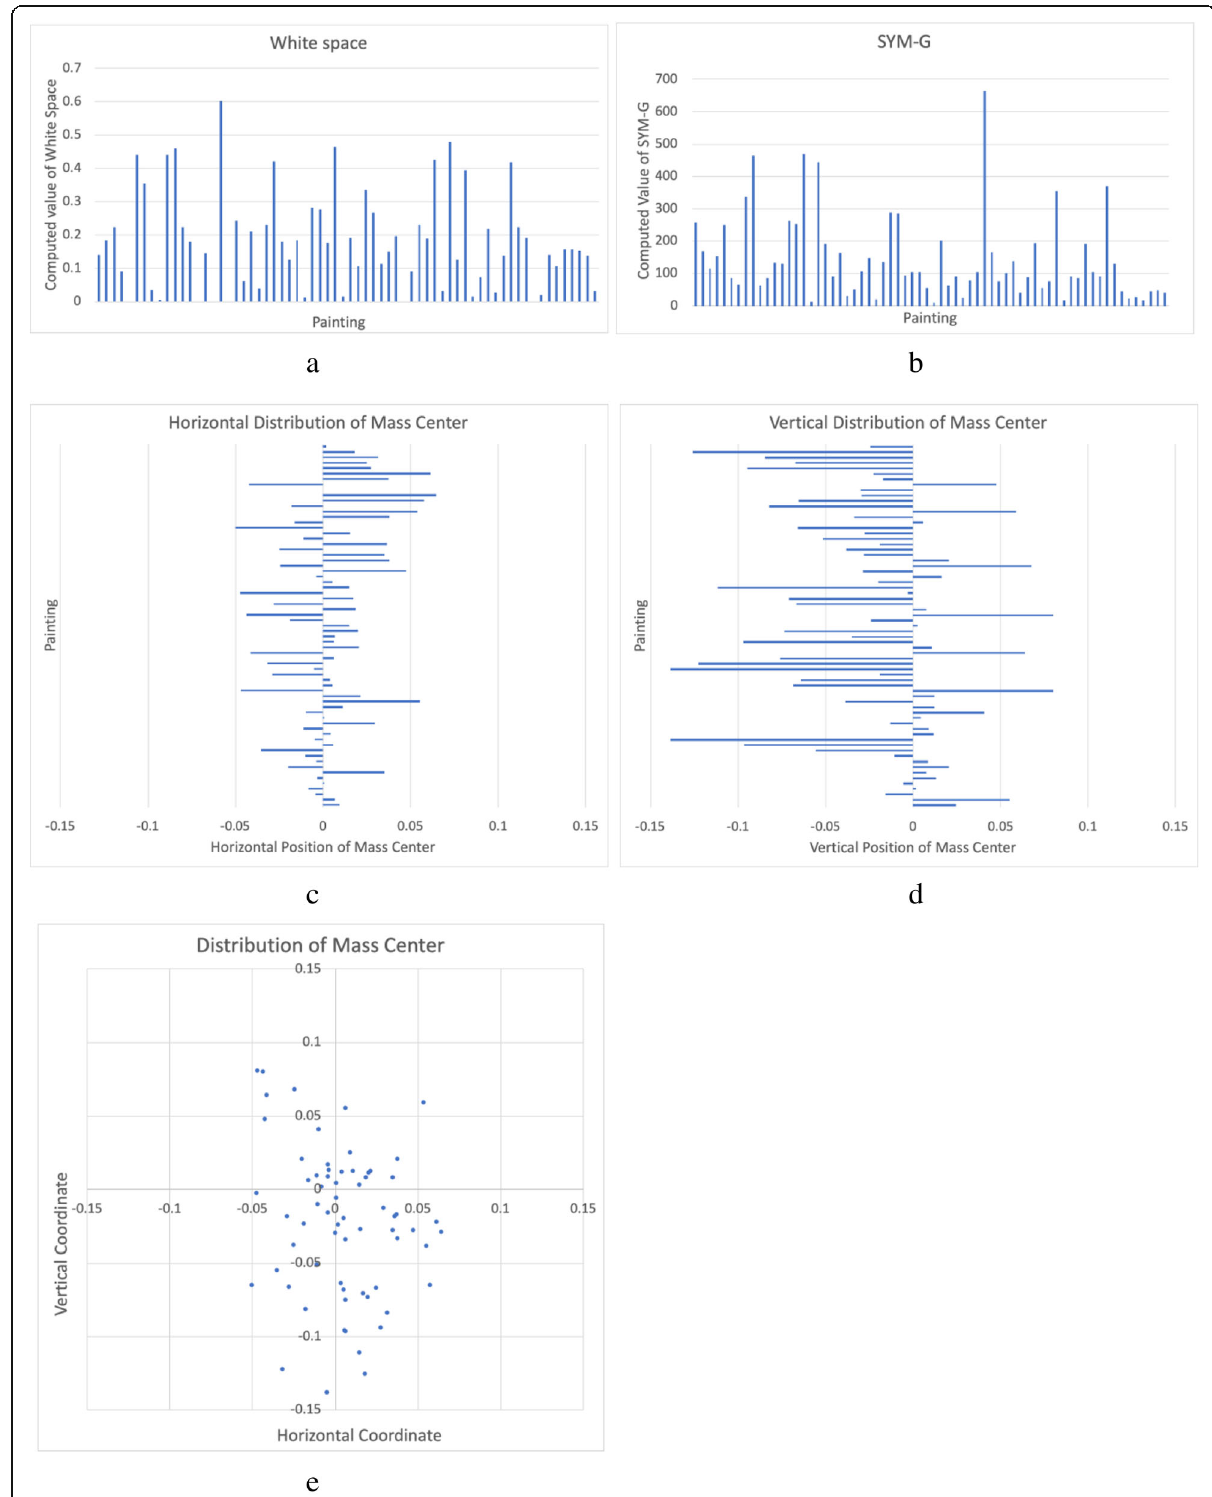
Fig. 3 The distribution of white space ( a ), SYM-G ( b ), horizontal coordinates ( c ) and vertical coordinates ( d ) of the mass center. The distributions of the relative coordinates of the mass centers on the